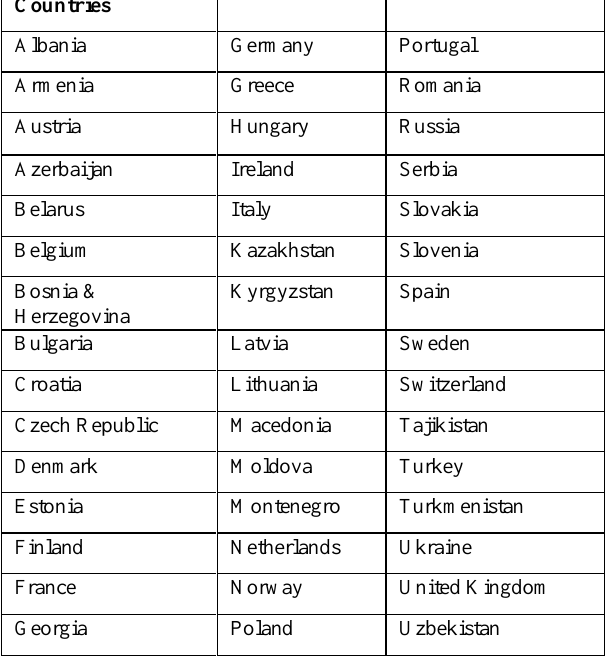
Table 15. Countries included in APD analysis.